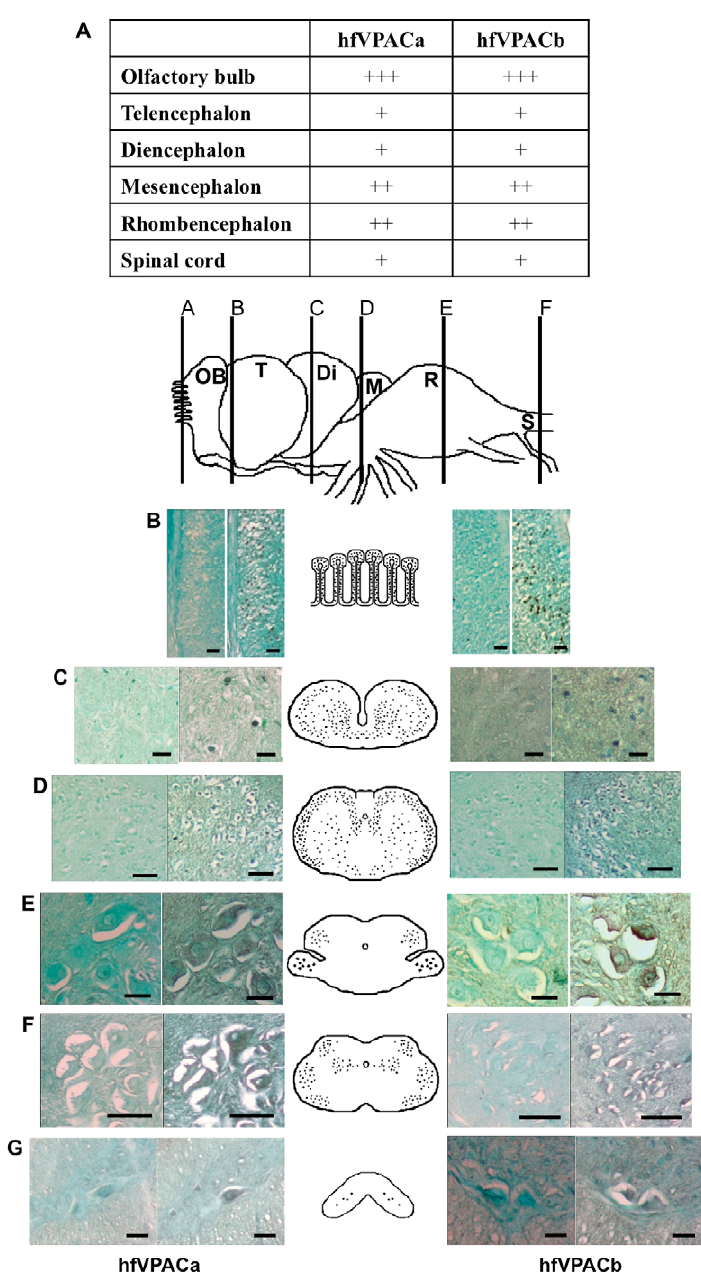
Figure 6. Insitu hybridization analysis of hfVPAC mRNAs in the brain of E.burgeri . (A) Summary of relative abundance of hfVPACa and hfVPACb receptor expressions in various brain regions: High ( +++ ), moderate ( ++ ), low ( + ), very low (–).The images and schematic diagrams show the distribution of hagfish mRNA in collateral sections of several brain regions (B–G). From left to right of the schematic diagrams, hfVPACa and hfVPACb images inclusive of their negative controls using a 1:30 ratio of DIG-labeled anti-sense probe and unlabeled anti-sense probe and positive signals using specific complementary probes are shown. Fast green was used for counterstaining. Scale bars, 0.25mm for B and D; 0.15mm for C, E–G.